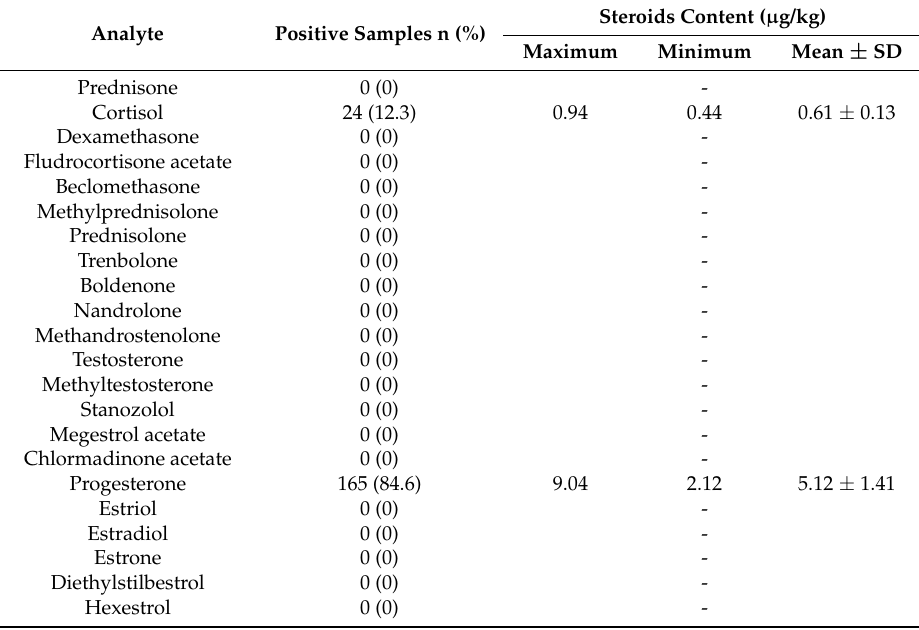
Table 3. The presence of steroids in raw